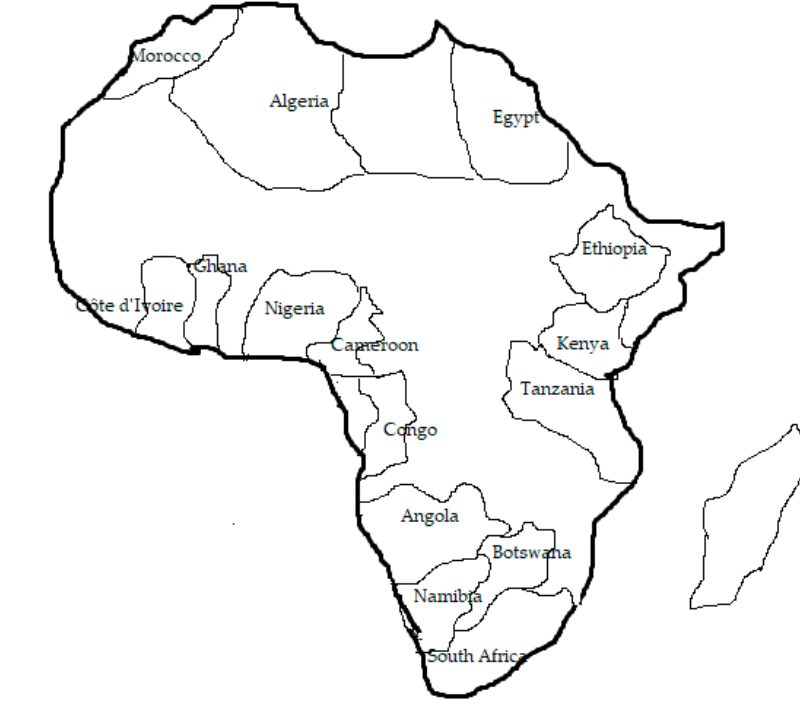
Figure 2. E-waste generated in 2019 by sub-region/inhabitant in Africa